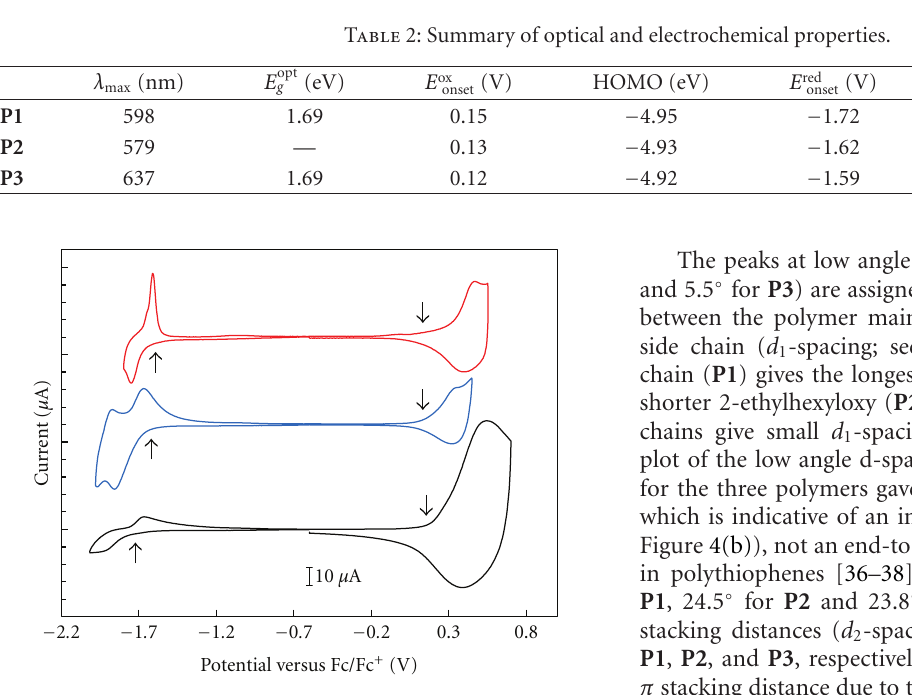
Figure 3: Cyclic voltammograms of P1 (black), P2 (blue), and P3 (red). Arrows indicate